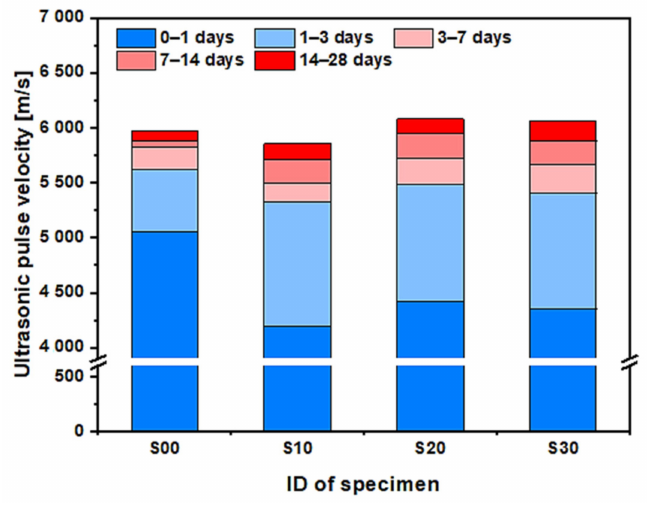
Figure 10. Ultrasonic pulse velocity development of each specimen according to the age